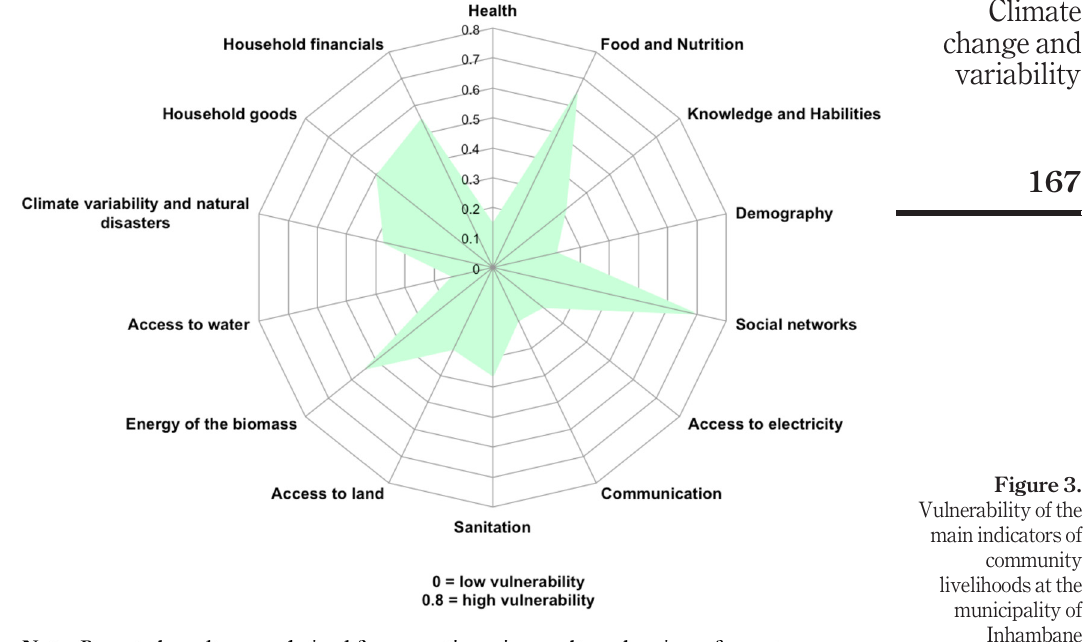
Figure 3. Vulnerability of the main indicators of